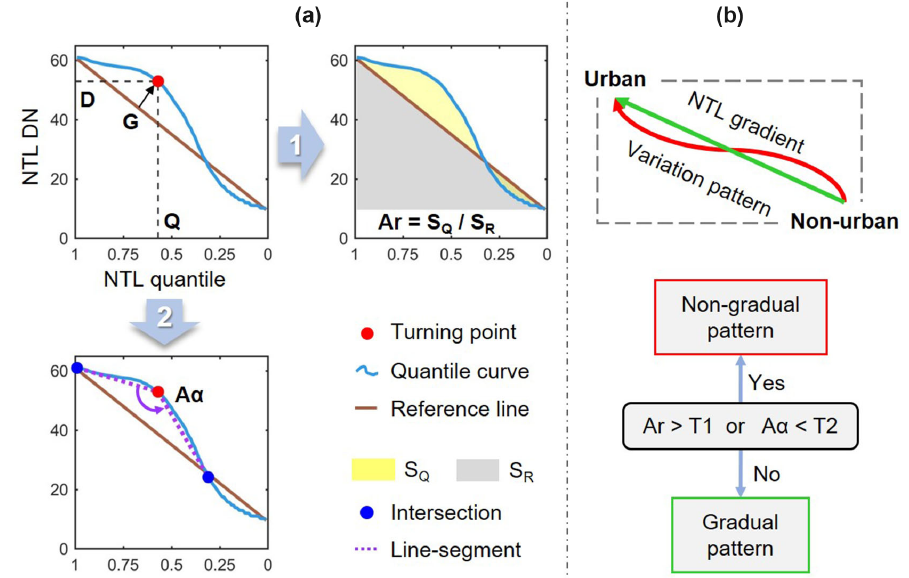
Figure 3. Identification of NTL gradient patterns. (a) The quantification of the two parameters for characterizing NTL gradient variations. D and Q represent NTL DN values and corresponding quantile levels; G represents the minimum distance between the reference line and the turning point. (b) The schematic diagram for identifying the variation pattern of the NTL spatial gradient in the potential urban